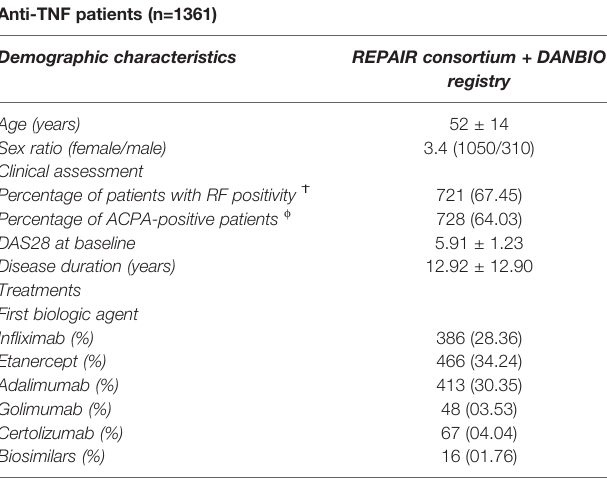
TABLE 1 | Demographic and clinical characteristics of anti-TNF